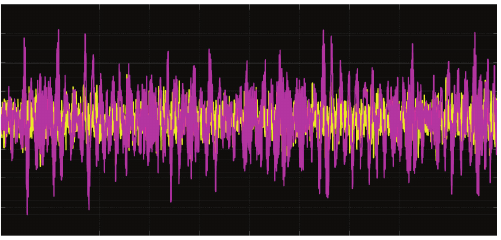
Figure 3: Vertical acceleration of the active and passive suspension.